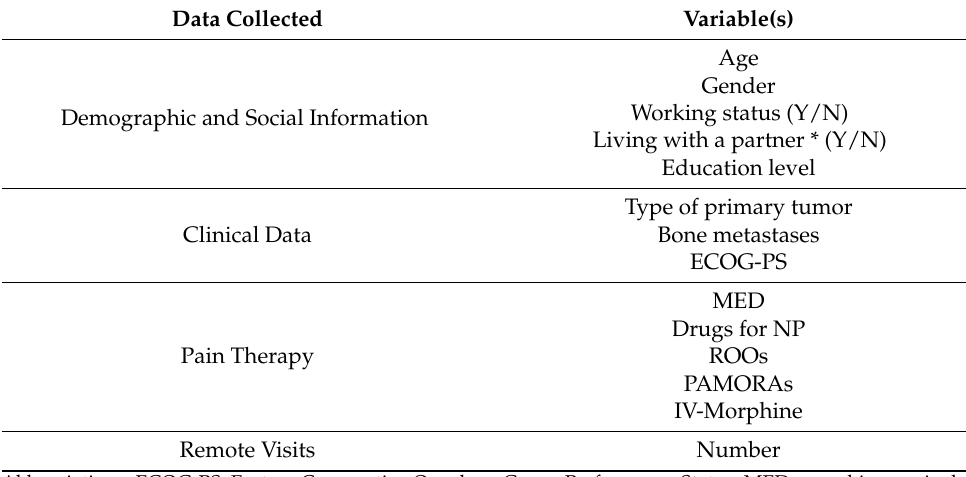
Table 1. Data collection and